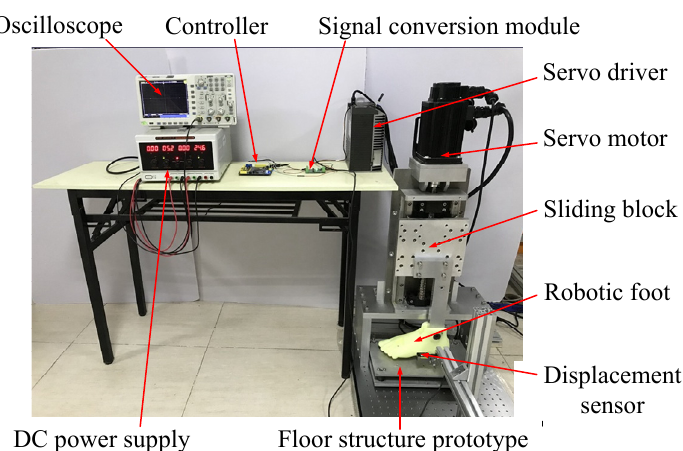
Figure 6. Prototype of stepping machine system (front view) and the testing setup.